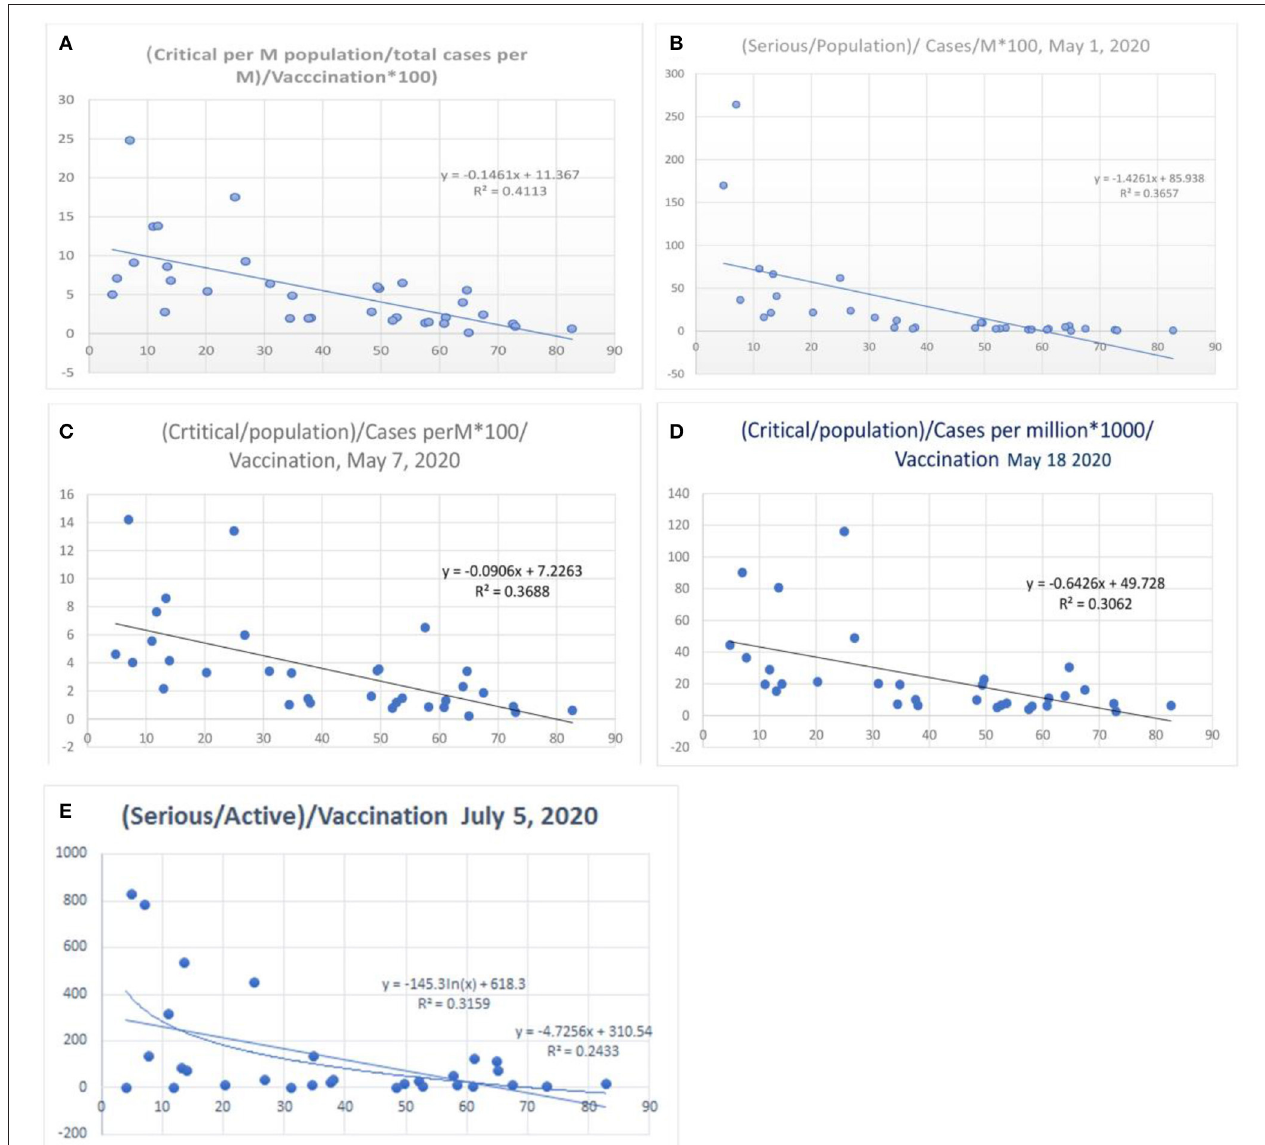
FIGURE 8 | Correlation between influenza vaccination percentage, and [(critical number/million population)/(total cases per million)]/vaccination percentage [ (A) April 26, 2020, (B) May 1, 2020, (C) May 8, 2020, (D) May 18, 2020 and (E) July 5, 2020].